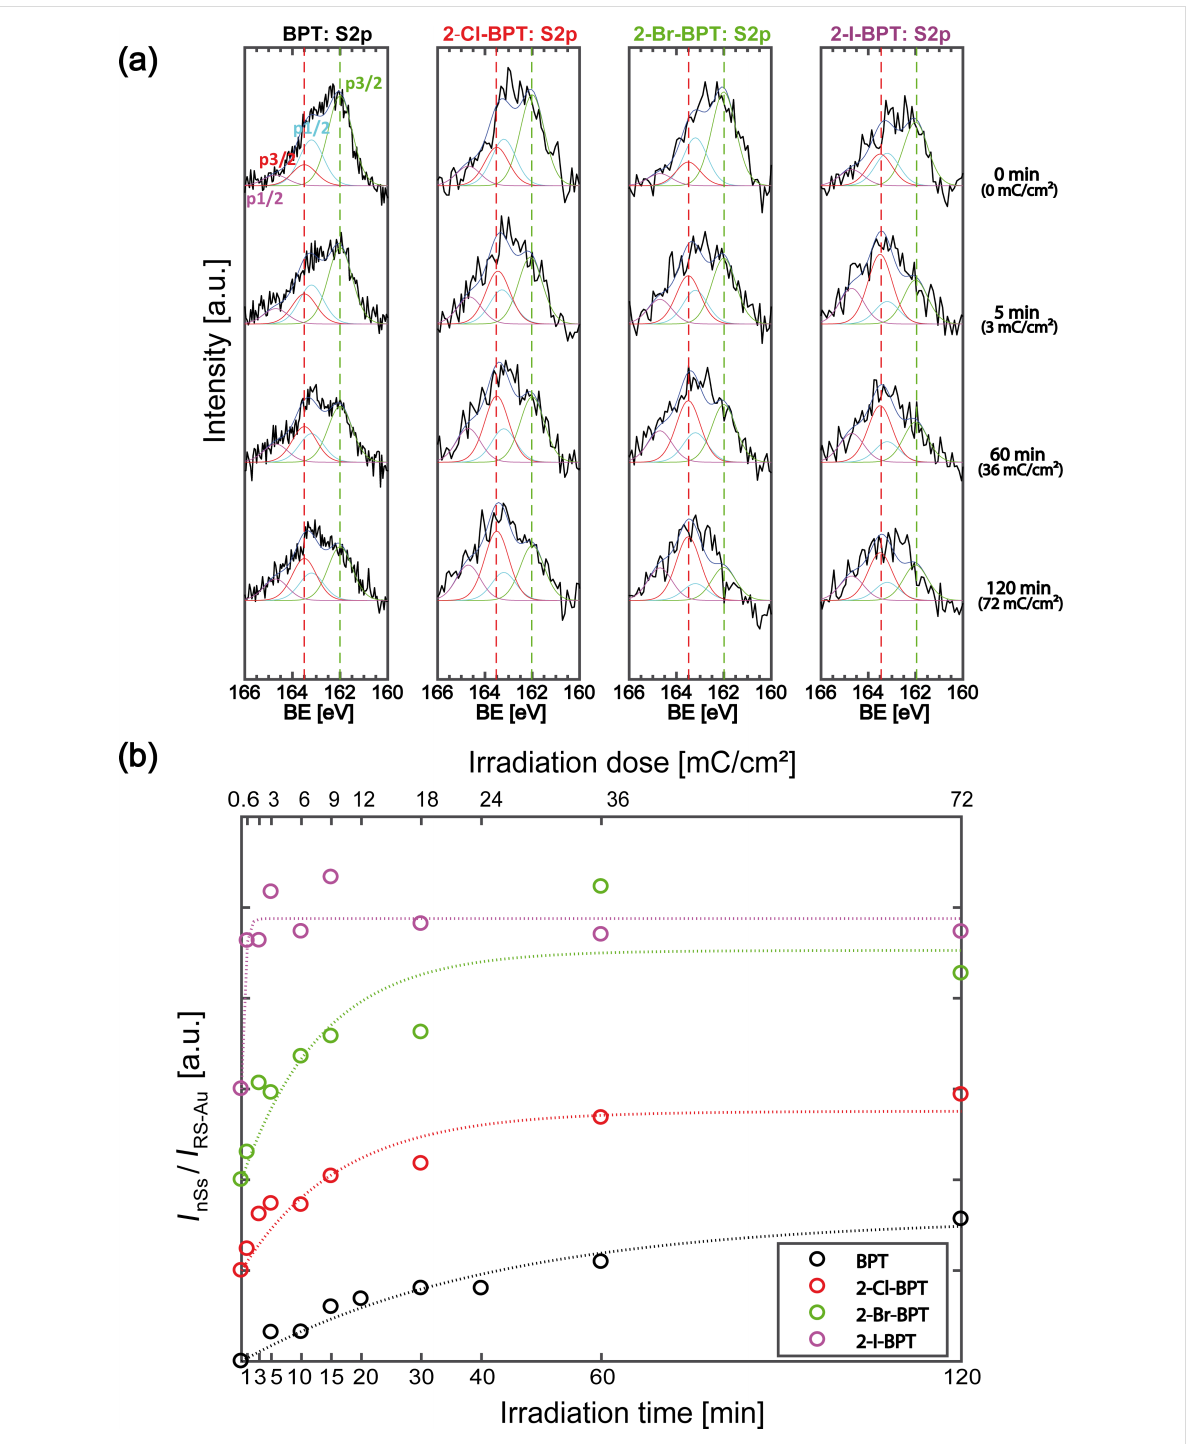
Figure 3: (a) Raw XP spectra of the S 2p region of SAMs made from BPT, 2-Cl-BPT 2-Br-BPT and 2-I-BPT before and after electron irradiation be- tween 0 and 120 min (electron dose: 0–72 mC/cm 2 ) equivalent to Figure 1. Fits are also shown using two S 2p 3/2 /S 2p 1/2 doublets with an energy separation of 1.2 eV [37]; one doublet has a S 2p 3/2 peak at 162 eV (green), and a S 2p 1/2 at 163.2 eV (blue), and corresponds to sulfur atoms in the native SAM (RS–Au); the second doublet has a S 2p 3/2 peak at 163.5 eV (red), and a S 2p 1/2 at 164.7 eV (purple), and corresponds to new sulfur species (nSs) produced as a result of electron irradiation. (b) Plot of the intensity ratios I nSs (162 eV)/ I RS-Au (163.5 eV) for the sulfur species of BPT and halogenated BPT as a function of irradiation time/dose. A saturation of the ratio can be interpreted as self-termination of the cross-linking of thiol substituted molecules [16]. Here, the raw data of the ratio is fitted by an unweighted exponential fit of the type A (1 − exp( − kx )), implying that 2-I-BPT cross-links the fastest, followed by 2-Br-BPT, 2-Cl-BPT and finally